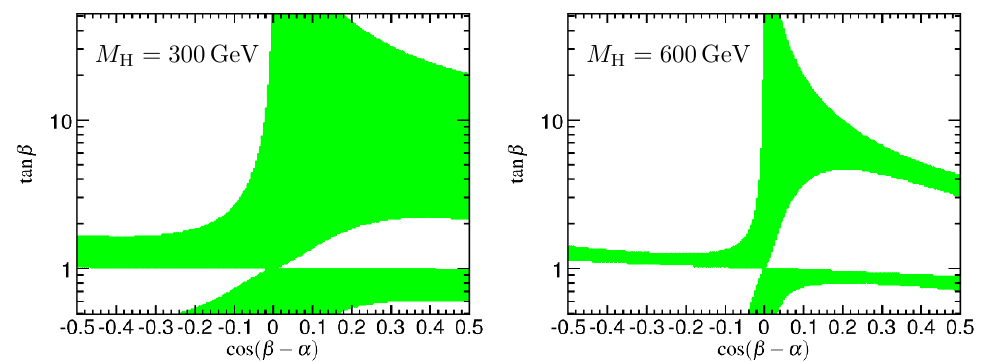
Figure 5 . Example THDM parameter regions respecting perturbative unitarity and stability con- straints (green) for the scenario of (cid:12)gure 4. The graphics are taken from ref. [13].